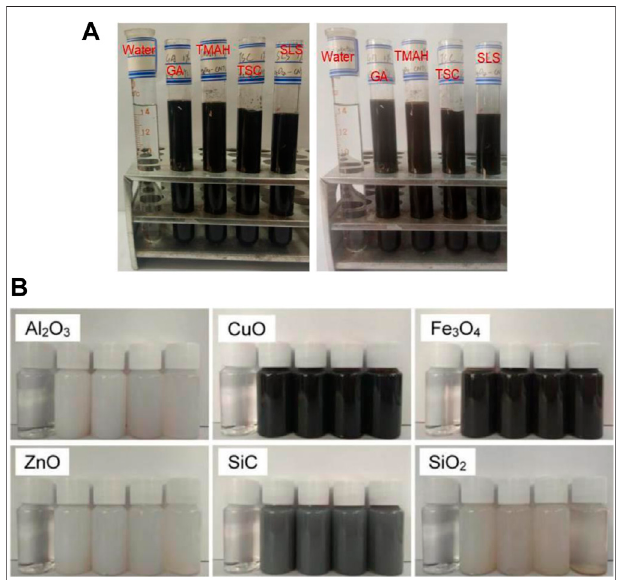
FIGURE 3 | Samples of various nano fl uids. (A) Fe 3 O 4 – CNT – water nano fl uid 5 h after preparation (left) and Fe 3 O 4 – CNT – water nano fl uid after 2 weeks (right) (Wang et al., 2021a). (B) Water-based nano fl uids with nanoparticles Al 2 O 3 , CuO, Fe 3 O 4 , ZnO, SiC, and SiO 2 [29].